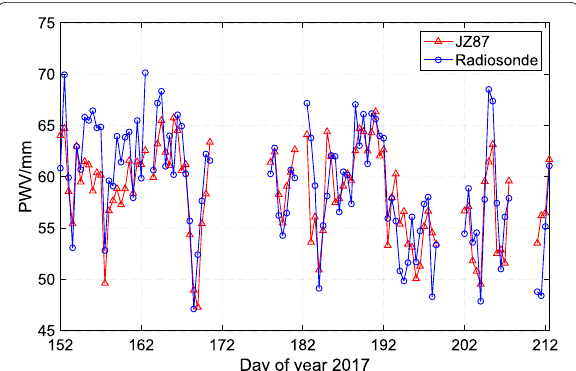
Fig. 5 Comparison of CNSS-PWV with RS-PWV at station JZ87